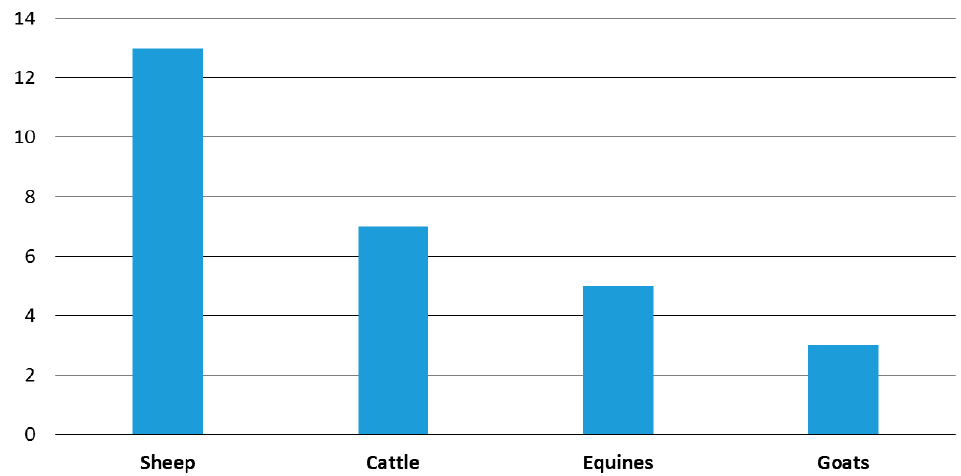
Figure 1. Number of empirical remedies documented for the treatment of specific domestic animal groups.